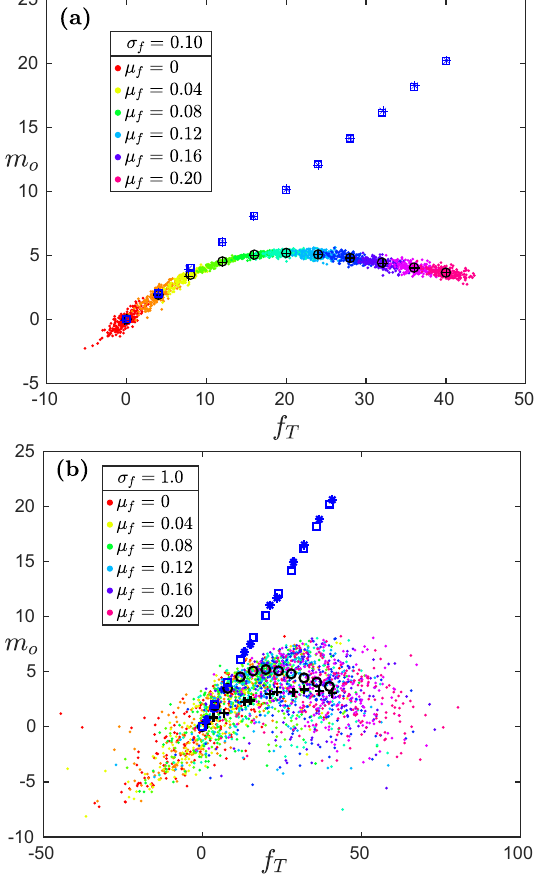
Figure 3. The influence of noise magnitude on the value of m o , the fiber bending moment at s = 0 for some fixed values of µ f (see inset of each figure). We show results for 2 di ff erent noise values. a) σ f = 0 . 1, b) σ f = 1 . 0. Open black circles represent deterministic configurations and black crosses correspond to the mean value of all realizations. The value of m Lo (small deforma- tion limit) has been also plotted for the corresponding determin- istic (blue squares) and realization mean values (blue